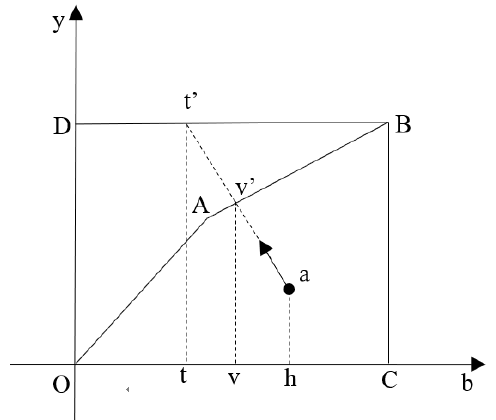
Figure 1. Graphical illustration of opportunity cost.